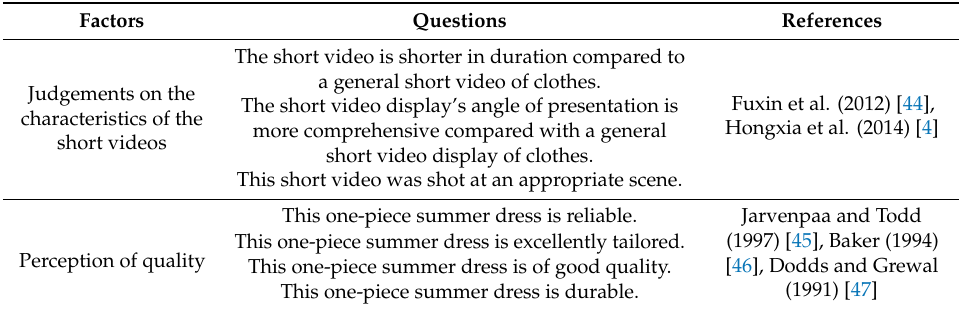
Table 3. The measurement